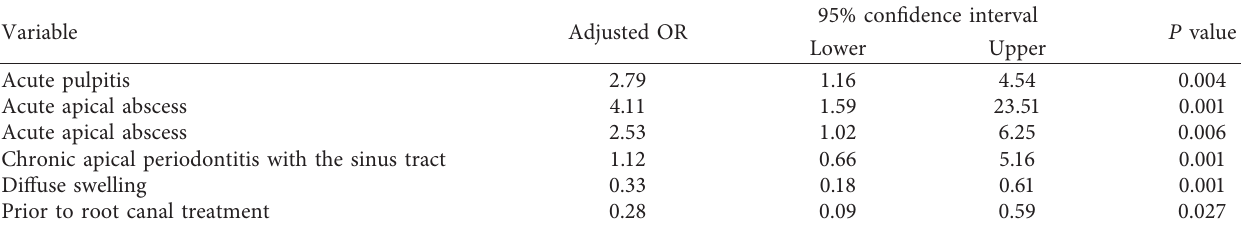
Table 5: Demographic factors associated with the prescribing pattern under different clinical